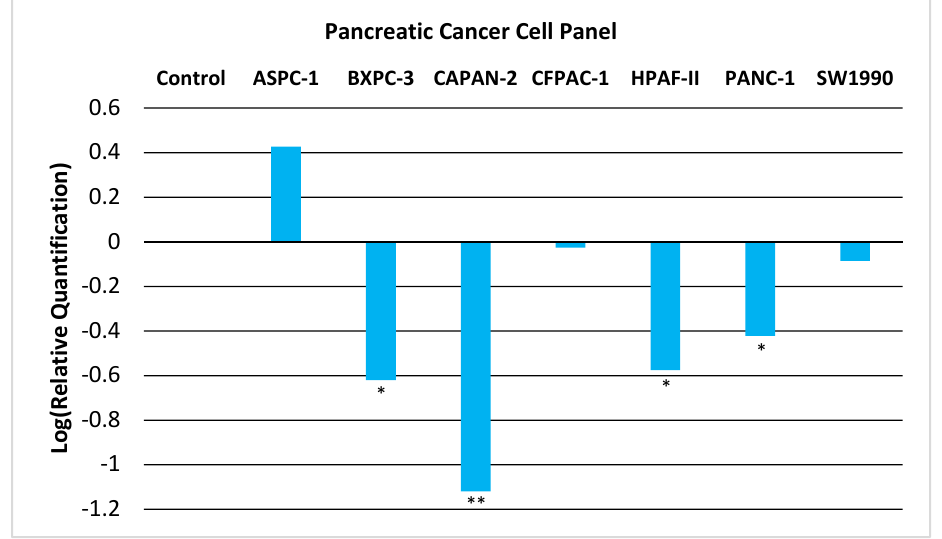
Figure 1. Relative Quantification (RQ) of the expression of GNMT in a Pancreatic Cancer Cell Panel by qRT-PCR. The expression of GNMT was determined and normalized to GAPDH. The Relative Quantification of the control cell line (H6c7) was set to 1 (log (RQ) = 0). Negative values for log 10 (RQ) indicate downregulation of GNMT. Significance from control, * p < 0.05; ** p < 0.005 (unpaired t-tests; n = 3).